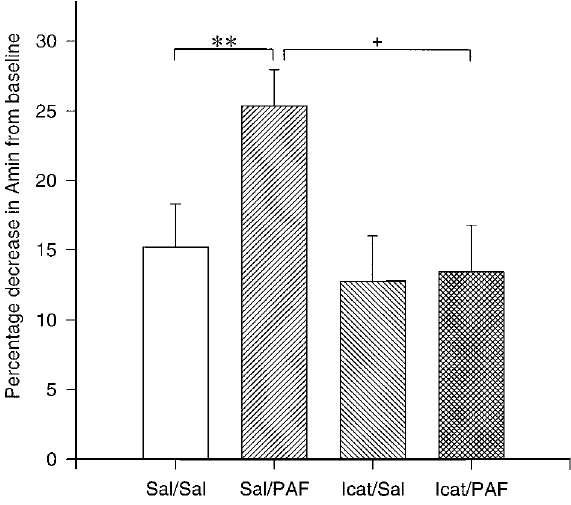
FIG. 5. The percentage decrease in the minimal cross- sectional area of the nasal airway (A min ) from baseline 10min after challenge with histamine, 200 m g. The nasal cavity was pretreated with saline (Sal), icatibant (Icat), 200 m g, and/or PAF, 60 m g, 6h prior to the histamine chal- lenge. Data are means± SEM from 15 subjects. **, + Sig- nificant increase in the histamine- induced percentage change in A min following saline/PAF pretreatment compared to pretreatment with saline only (** P <0.01, Wilcoxon sign- rank test) or icatibant/PAF ( + P <0.05, Wilcoxon sign-rank test).